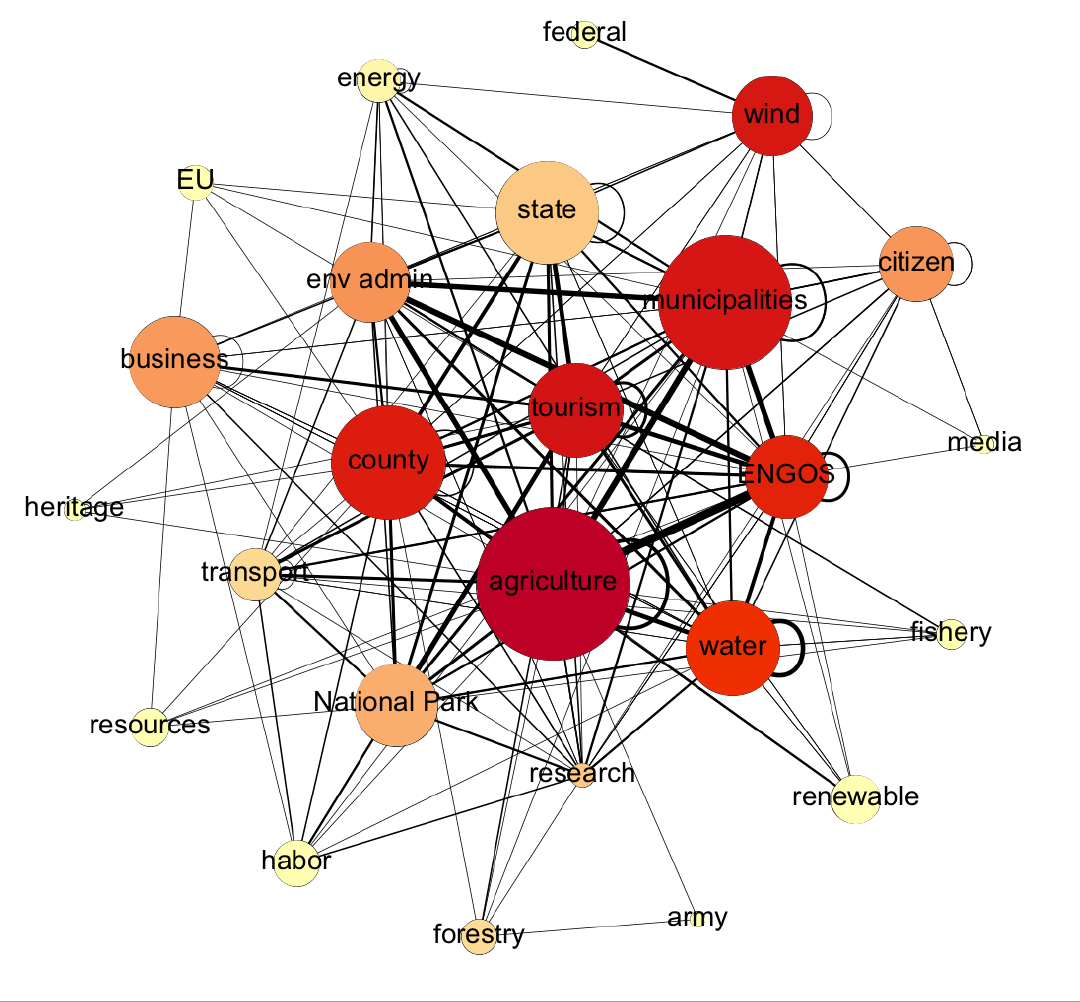
Fig. 2. Aggregated social network of the EFP as perceived by interview partners. Color intensity represents the betweenness centrality value (the redder/darker, the higher). Width and line color show how often a certain relationship was mentioned. The size of the bubbles illustrates the perceived influence (the bigger, the more